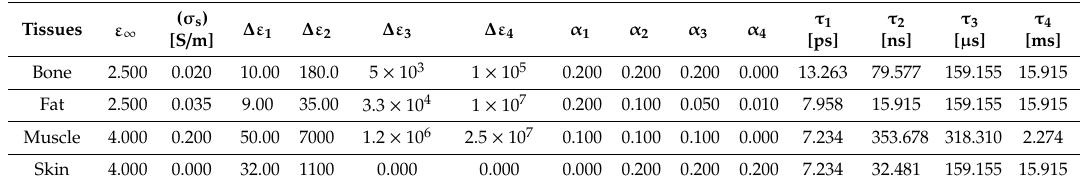
Table A1. Parameters of the 4-pole Cole–Cole formulation from [30], in a frequency range from 10 Hz to 20 GHz, for the cervical tissues represented in the 3D anthropomorphic phantoms resulting from the developed phantom generator.